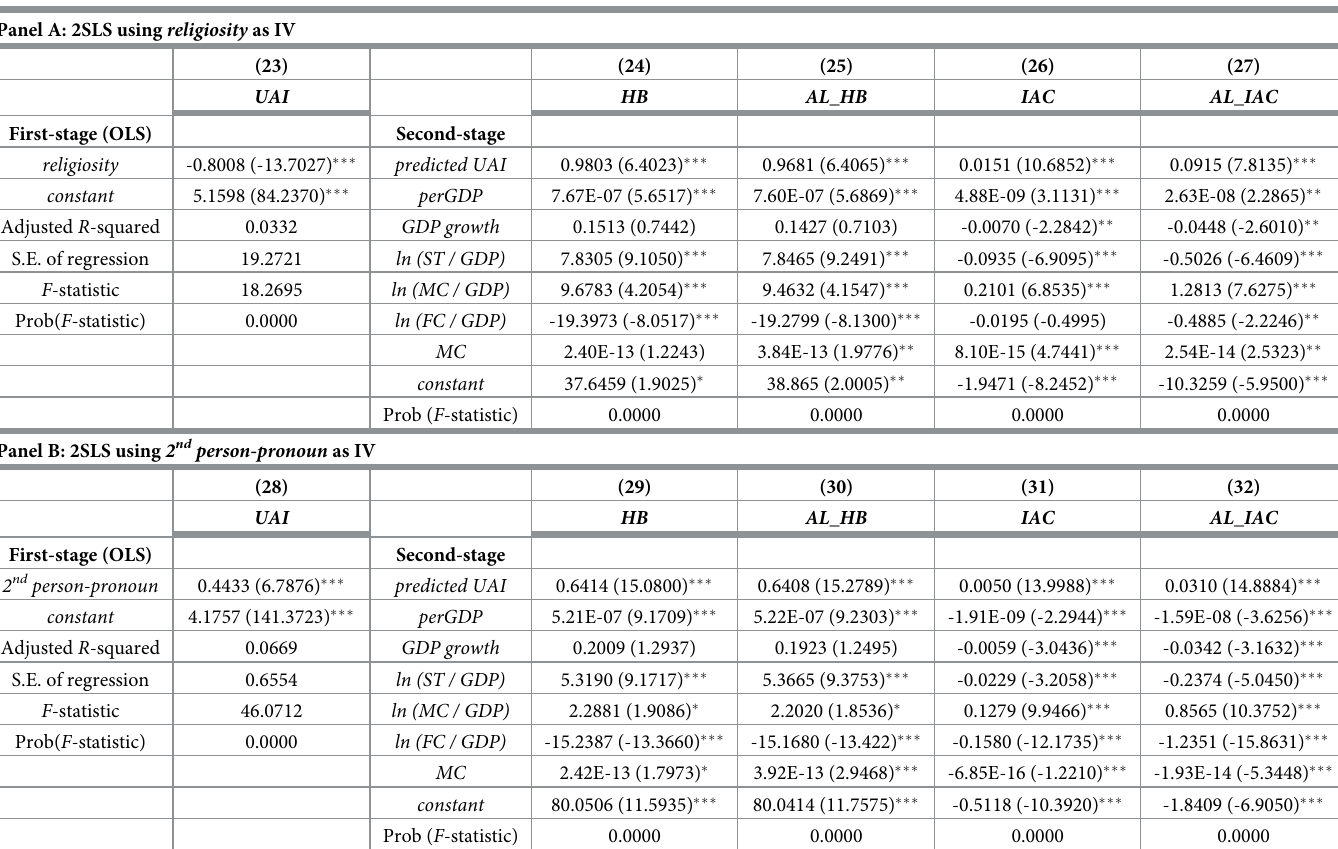
Table 6. The robustness results using the 2SLS method with IVs. Panel A: 2SLS using religiosity as IV